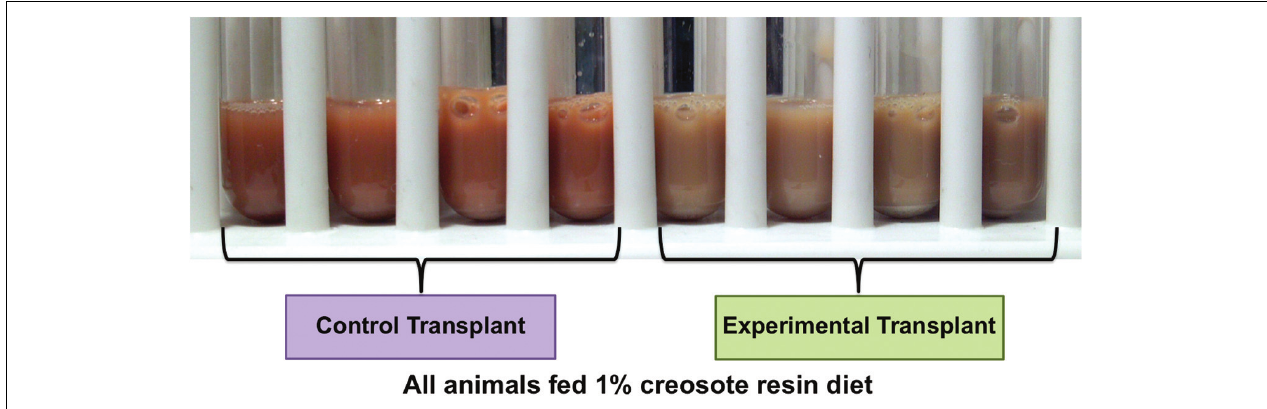
FIGURE 2 | Urine collected during the microbial transplant experiment described in Kohl et al. (2014d).